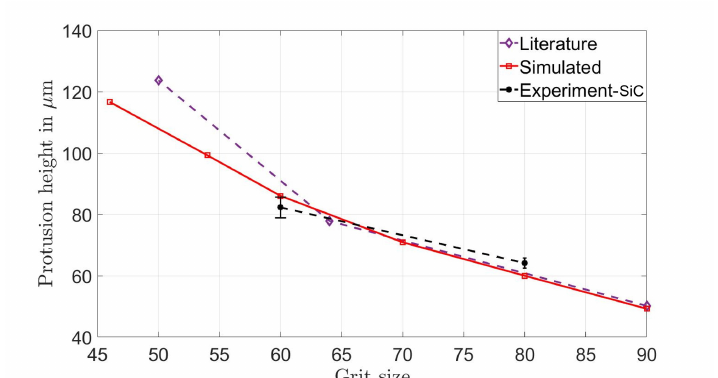
Figure 30. Comparison of simulated protrusion height values with measured values from experi- ments and the literature